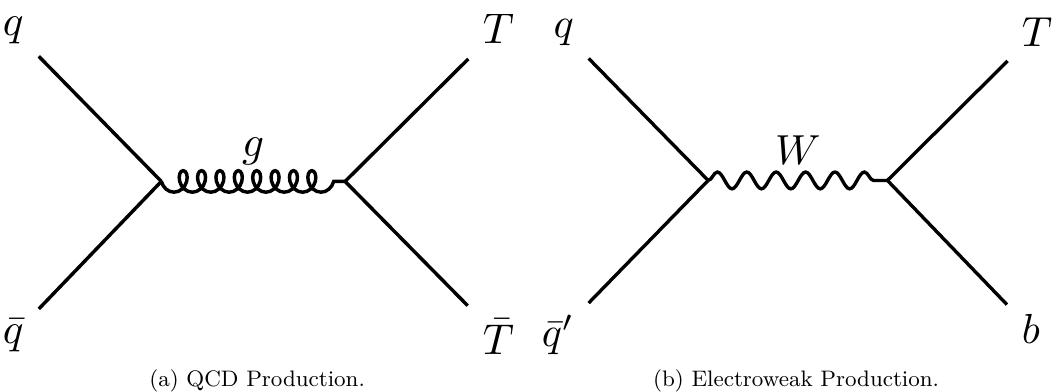
Figure 1 . Feynman diagrams for T pair production via gluon-mediated QCD (left) and T produc- tion via electroweak processes (right). These processes have been studied in previous experimen- tal